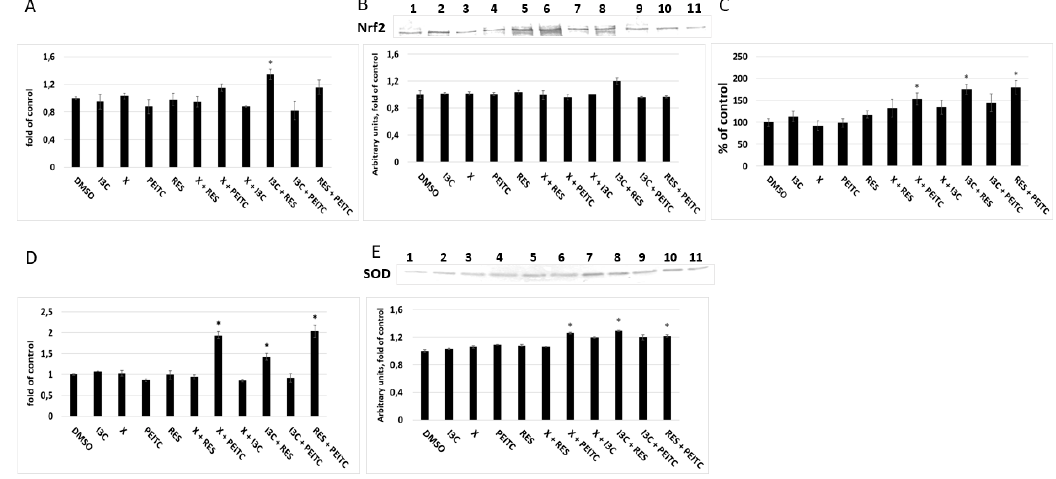
Figure 1. The effect of phytochemicals and their combinations on Nrf2 and SOD expression in MIA- Pa-Ca-2 cells. ( A ) Nrf2 transcripts calculated as mRNA level in comparison with control cells (expression equals 1). ( B ) Representative immunoblots for the analysis of the nuclear level of Nrf2 protein. Lane 1—control; lane 2—I3C 1 μ M; lane 3—X 1 μ M; lane 4—PEITC 1 μ M, lane 5—RES 1 μ M; lane 6—X + RES 1 μ M; lane 7—X + PEITC 1 μ M; lane 8—X + I3C 1 μ M; lane 9—I3C + RES 1 μ M; lane 10—I3C + PEITC 1 μ M; lane 11—RES + PEITC 1 μ M. Results of Western blot analysis were expressed as nuclear protein level in comparison with control cells (expression equals 1). ( C ) Binding of Nrf2 to ARE–containing oligonucleotide, the values were calculated and compared with control level, equals 100%. ( D ) SOD transcript levels. ( E ) Representative immunoblots for the analysis of SOD protein. The data are presented as mean ±SEM. The asterisk (*) above the bar denotes statistically significant differences to the control group, p <